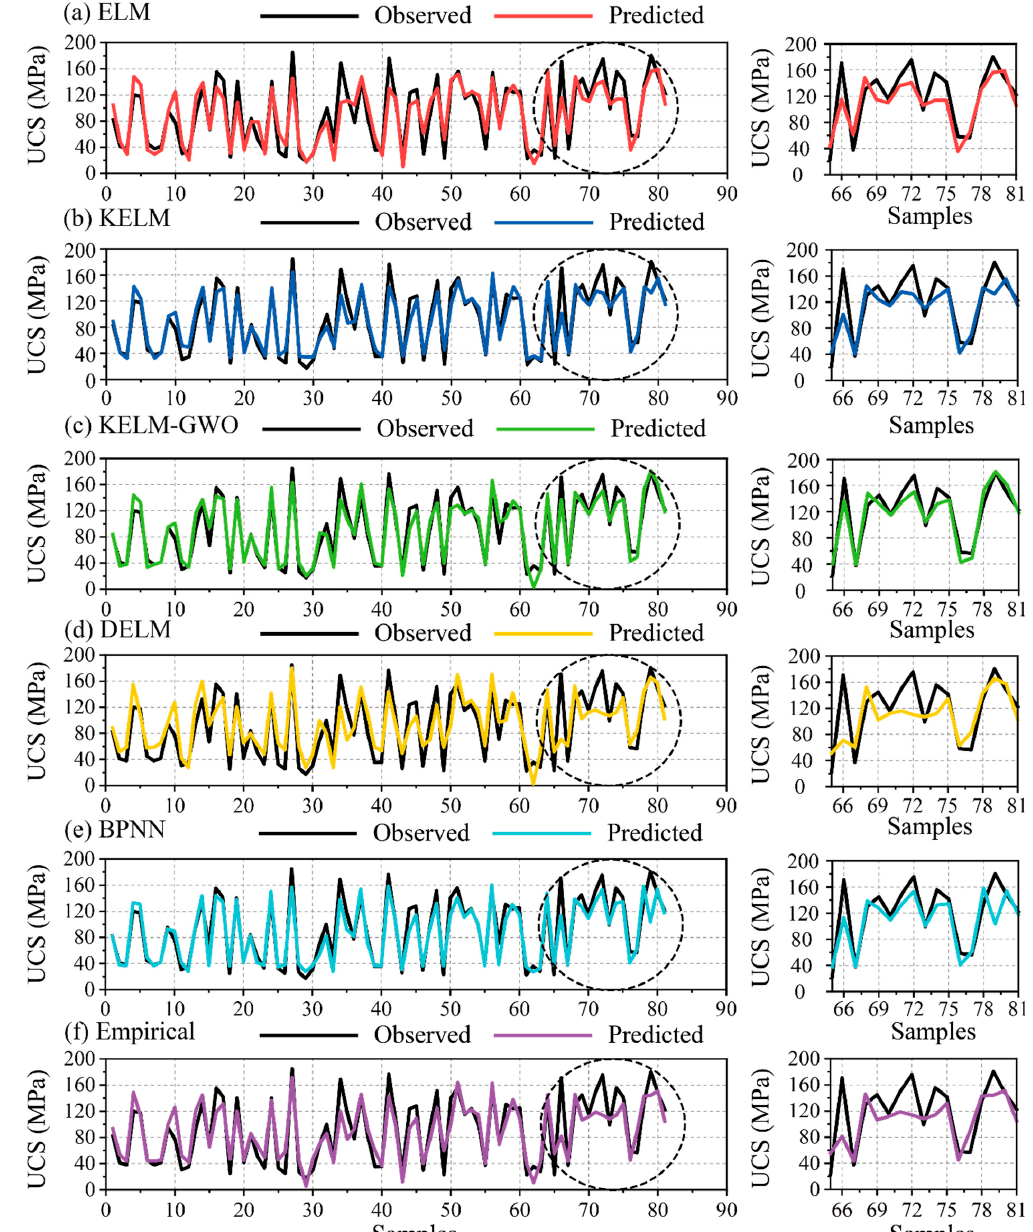
Figure 11. The curves of predicting FD in the testing phase by all models The graphical Taylor diagrams can be a concise tool for evaluating the performance of the models more comprehensively, as shown in Figure 12. A complete Taylor diagram consists of three parts: standard deviation (blue circles), RMSE (green circles), and corre- lation coefficient (black dotted lines). The RMSE and correlation coefficient of the ob- served value was 0 and 1; the standard deviation, RMSE, and correlation coefficient of all models can be calculated based on their predicted values. Accordingly, the highest simi- larity to the observed data corresponded to the best prediction model. As can be seen in